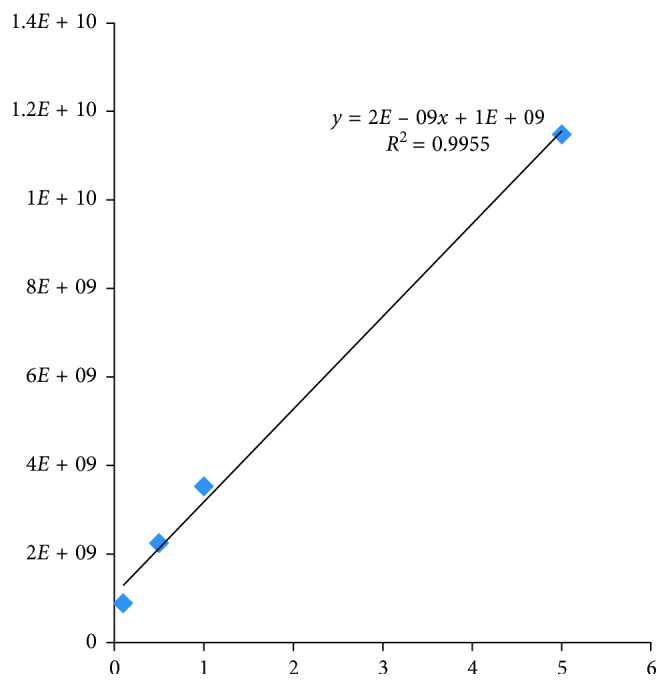
Determination of pulegone concentration by comparing the standard samples.